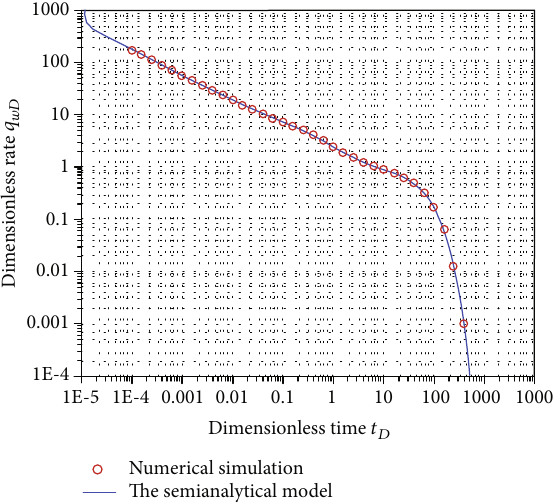
Figure 3: Comparative veri fi cation of the presented semianalytical model with the numerical simulation